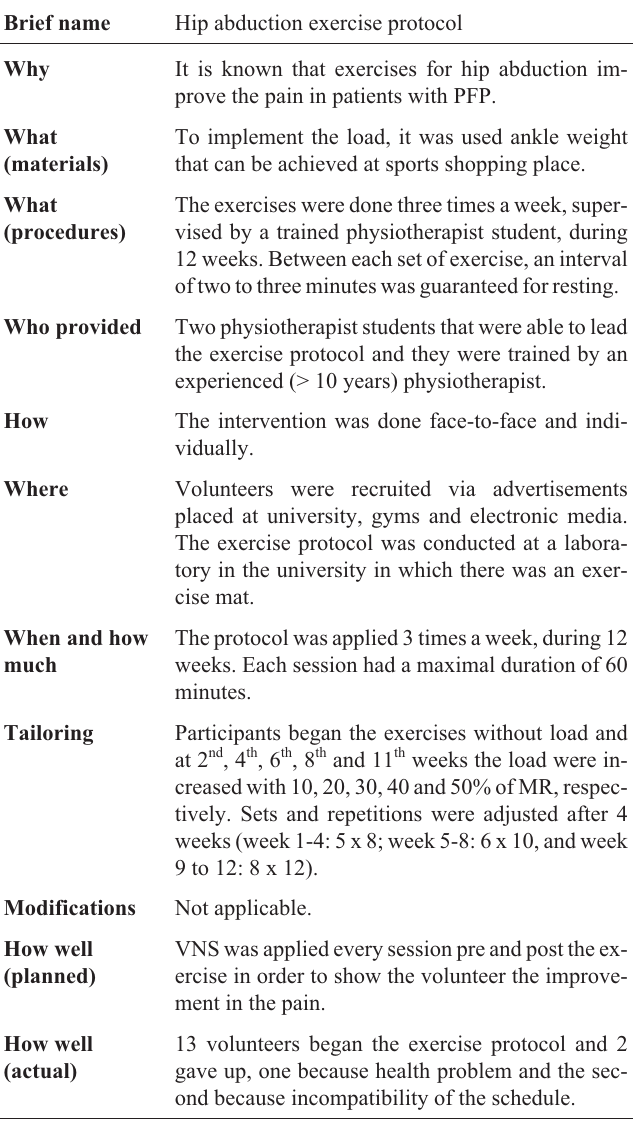
Table 2 - TIDIER checklist for the hip abduction exercise protocol 30